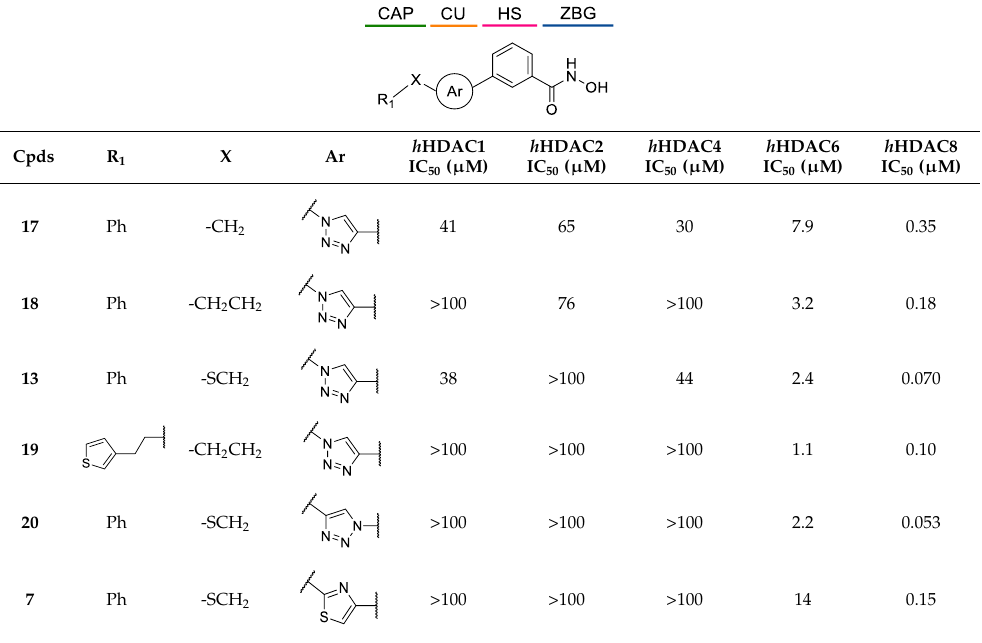
Table 2. General structure and IC 50 values of HDAC8 inhibitors bearing five-membered-based linker ( 7 , 13 , 17 – 20 ) [141,142].